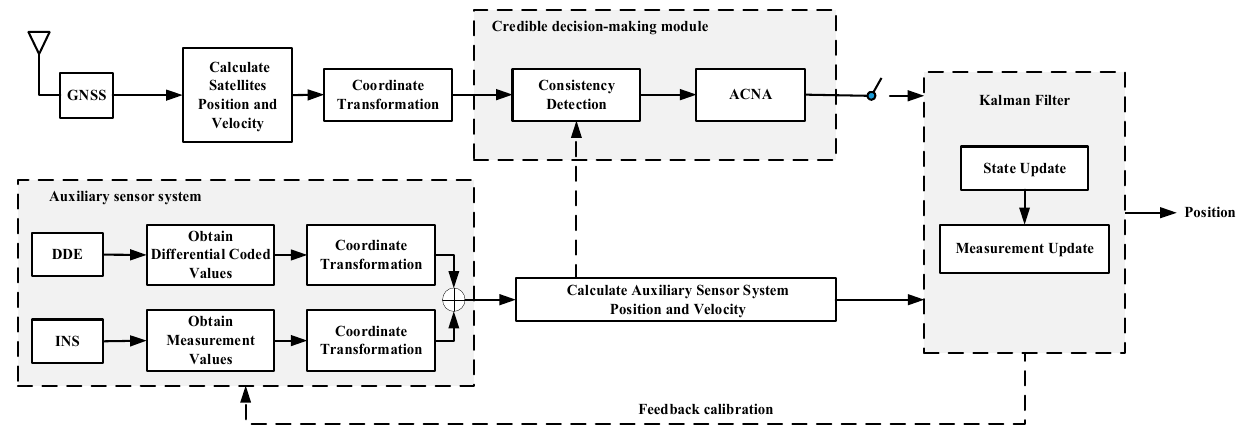
Figure 1. Credible Kalman filter model.